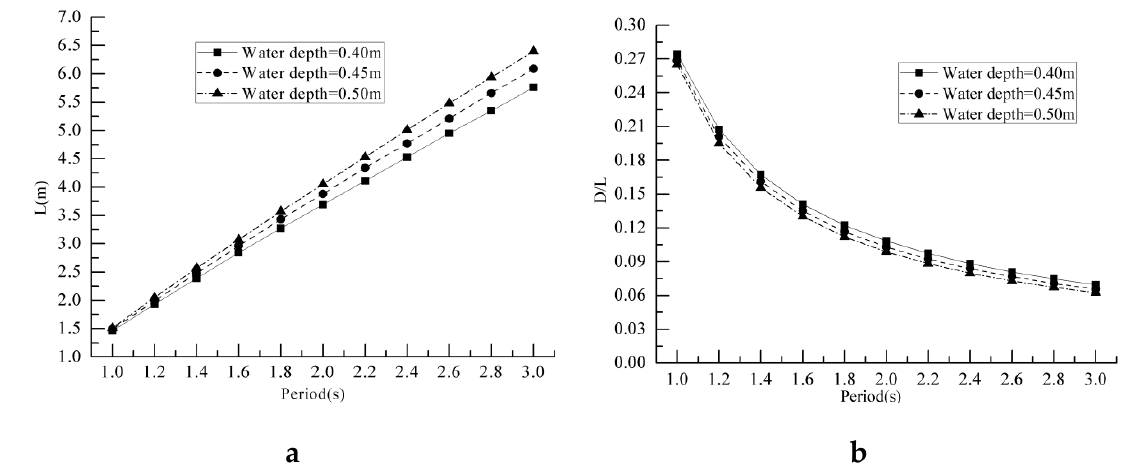
Figure 9. Variation of wave conditions with wave period for three water depths: ( a ) wave length ( L ); ( b ) diameter to wave length ( D/L ).